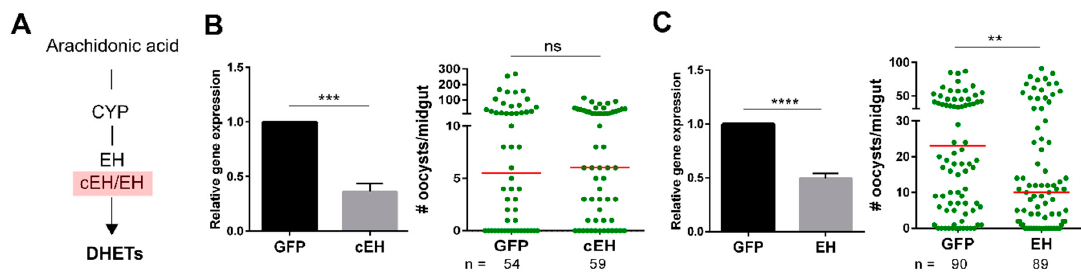
Figure 2. Effect of putative genes involved in dihydroxyeicosatrienoic acid (DHETs) biosynthesis on Plasmodium oocyst survival. By summarizing recent studies on functional characterization of insect orthologous genes to human epoxide hydrolase (EH), orthologous genes (cEH and EH in pink boxed) in An. gambiae were selected for RNAi experiments ( A ). The efficiency of gene-silencing was verified by qRT-PCR and the effects of the gene knockdown on oocyst survival were evaluated for either cytoplasmic epoxide hydrolase (cEH) ( B ) or EH ( C ) and compared to green fluorescent protein (GFP) controls. qRT-PCR data were analyzed by an unpaired t-test. Bar graphs represent mean ± SEM of three independent experiments. Data from oocyst assessment were pooled from three or more independent experiments with statistical analysis determined by a Mann–Whitney test using GraphPad Prism 6.0. Asterisks denote significance ( ⋆⋆ p < 0.01, ⋆⋆⋆ p < 0.001, ⋆⋆⋆⋆ p < 0.0001); ns, not significant. CYP, cytochrome P450.